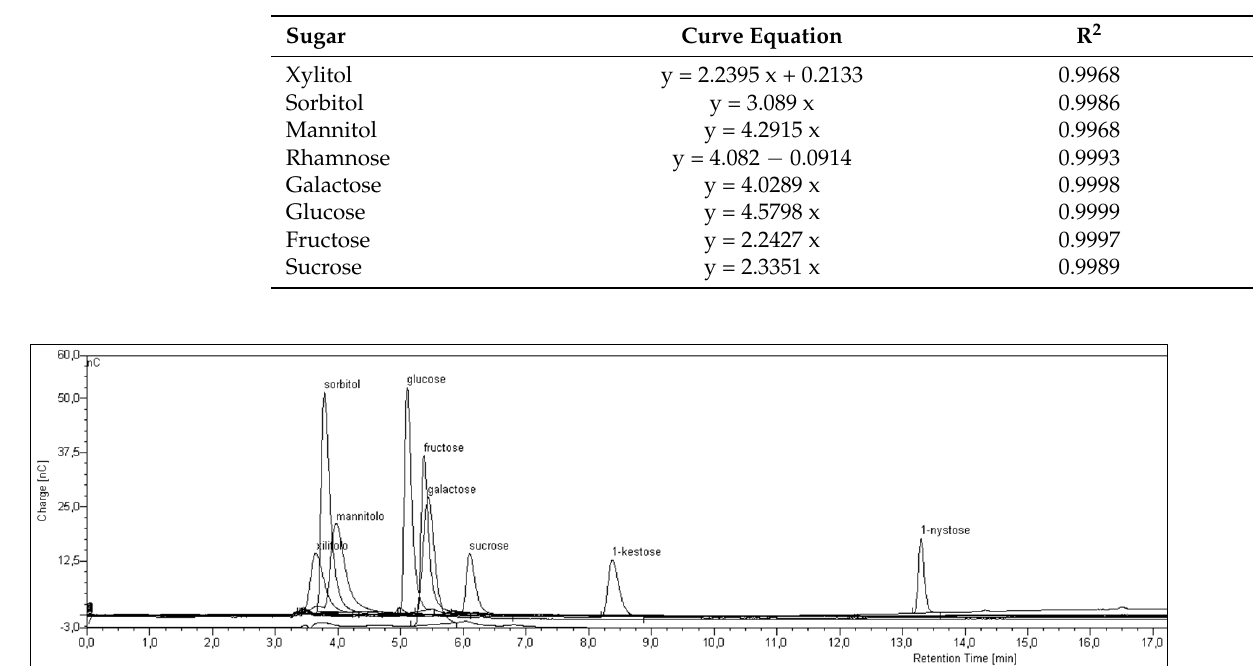
Table A4. Calibration curve equations of standards injected in PA1 column.